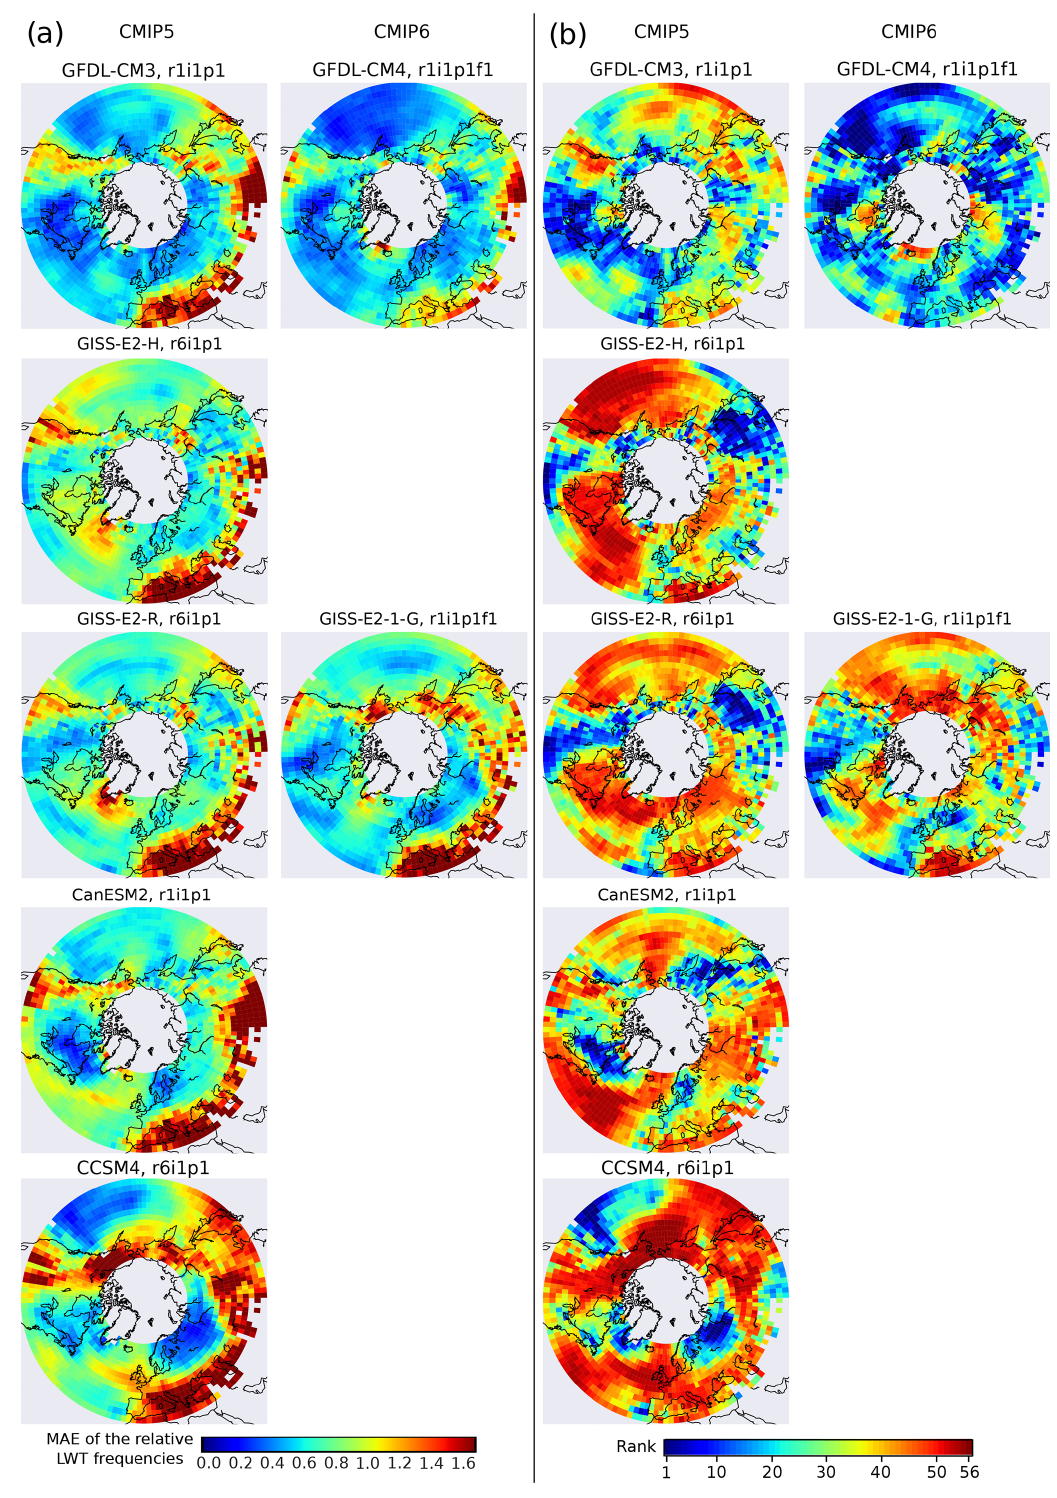
Figure 4. As Fig. 3 but for the GFDL, GISS, CCCma and NCAR models.